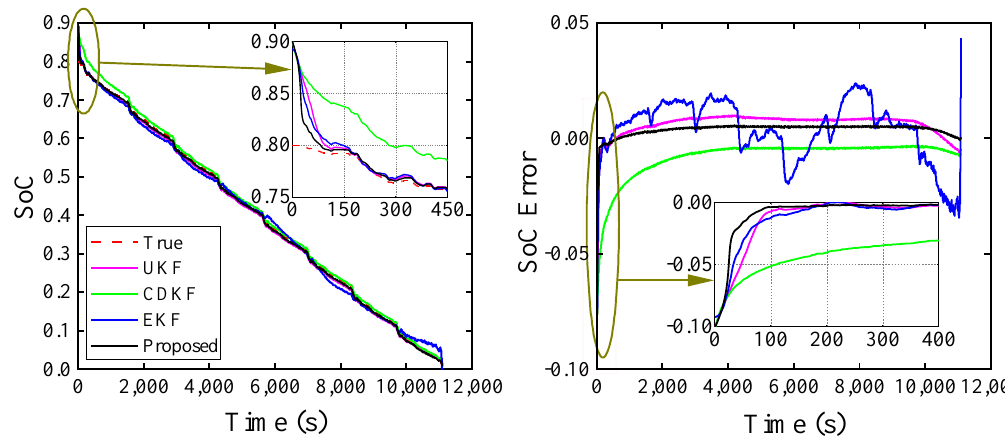
Figure 10. The initial SoC guess was 0.9 under the FUDS condition.